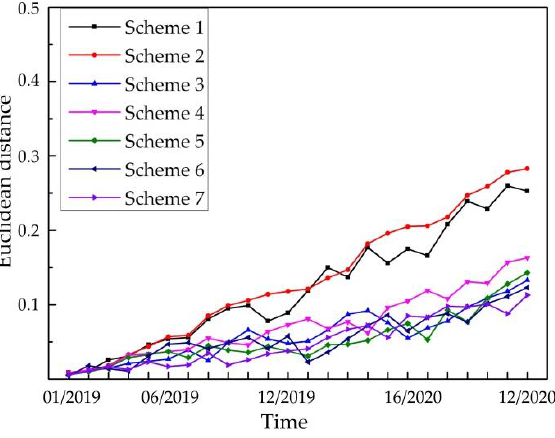
Figure 22. Euclidean distance of seven features fusion methods.